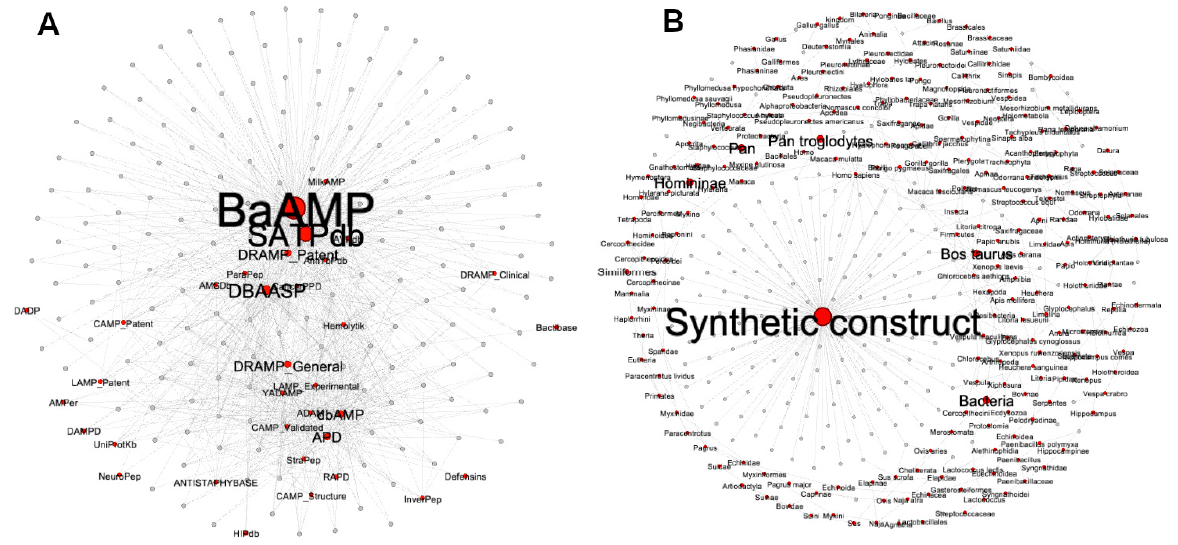
Figure 5. METNs’ visualization using the Fruchterman–Reingold layout. Red nodes represent the metadata, while the ABFPs are in gray color. ( A ) METN built with the source database information. ( B ) METN built with the origin information.